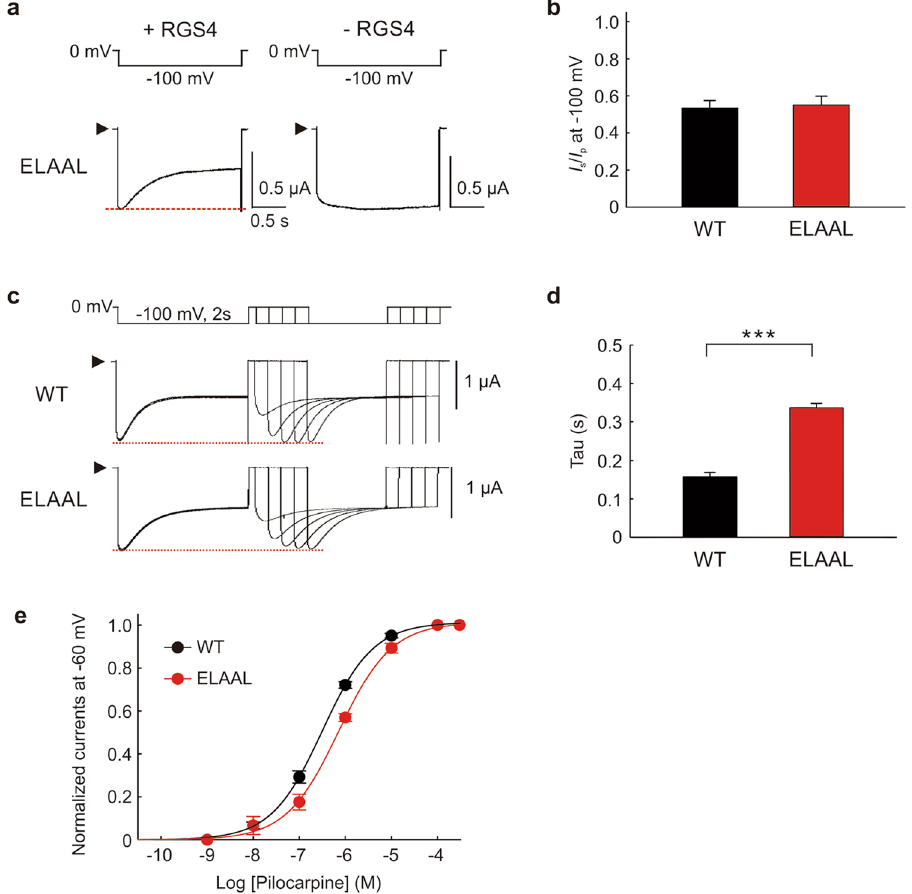
Figure 5. Effects of mutations in the intracellular loop 3 of M2 muscarinic receptor on the voltage-dependent response of GIRK currents. ( a ) Pilocarpine (100 µ M)-induced GIRK currents in oocytes expressing M2 muscarinic receptor mutant ELAAL with ( left panels ) and without ( right panels ) RGS4 were recorded at − 100 mV as shown above. ( b ) The ratio of I s to I p ( I s / I p ) of M2 muscarinic receptor WT and ELAAL at –100 mV in the presence of pilocarpine (100 µ M). ( c ) Recoveries of pilocarpine (100 µ M)-induced GIRK currents from hyperpolarization-mediated desensitization of channels in oocytes expressing WT and ELAAL M2 muscarinic receptors were recorded with a protocol shown above the current traces. ( d ) The time constant (tau) of I p recovery times in c were calculated with exponential curve fitting. ( e ) Concentration-response curves of pilocarpine-induced GIRK currents were fitted with the Hill equation. The maximal value of pilocarpine- induced GIRK current was normalized to 1. The − logEC 50 was 6.51 ± 0.02 for WT; 6.15 ± 0.02 for ELAAL. Data in b , d and e are means ± s.e.m., n = 6. *** Indicates a statistically significant difference ( P <